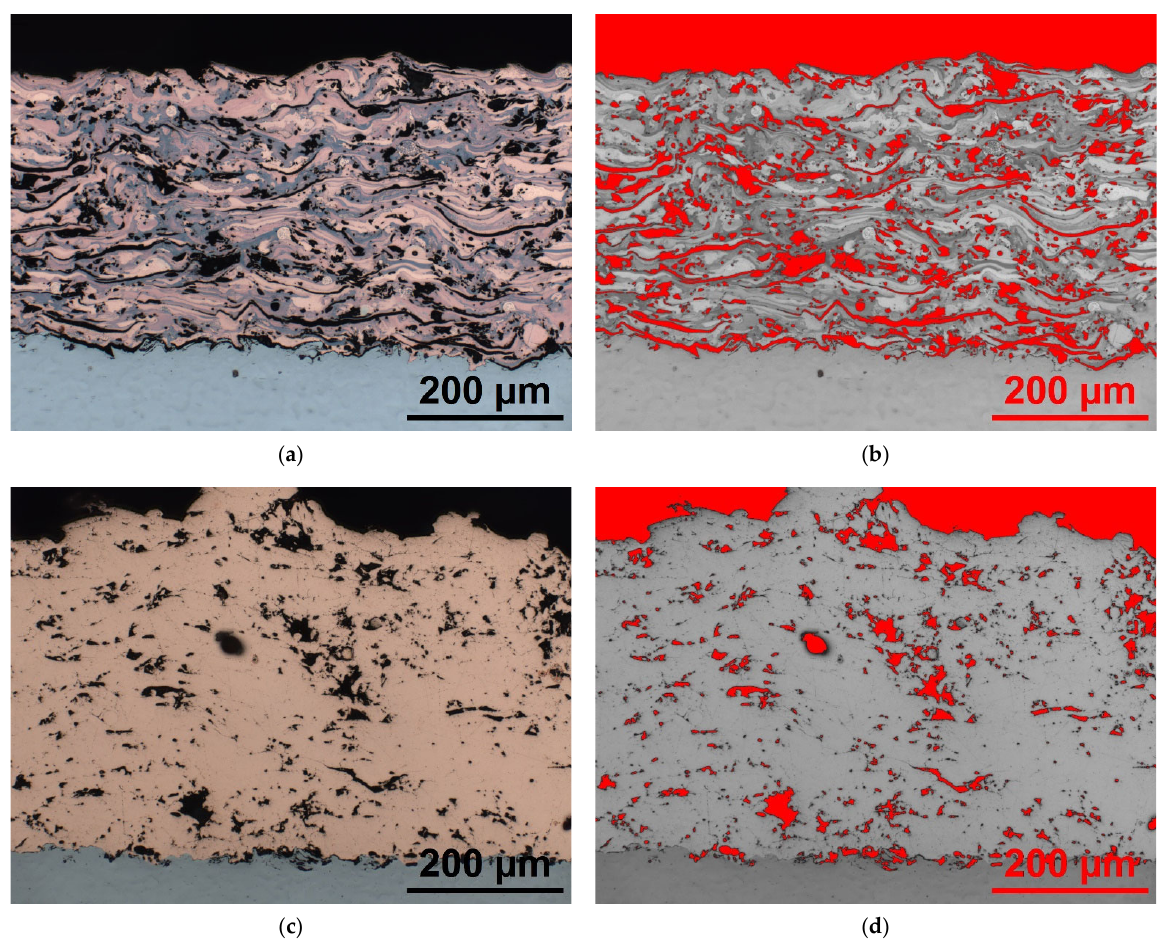
Figure 4. Reflected light microscopy images obtained on cross sections of: ( a ) conventionally in air sprayed wire arc copper coating with ( b ) porosity analysis and ( c ) copper coating created in an environment with an oxygen content of 1 × 10 − 26 vol. ‐ % with ( d ) porosity analysis. the substantial effect obtained upon transferring the corundum blasting process to XHV ‐ adequate environment. The copper coatings produced in the oxygen ‐ free environment were free of oxide fringes. Furthermore, the gaps at the interface between the substrate surface and the coat ‐ ing surface were significantly reduced in this case, and few interlamellar gaps were pre ‐ sent. Moreover, the coating porosity was noticeably reduced from 17.5% (Figure 4b) to 5.3% (Figure 4d).